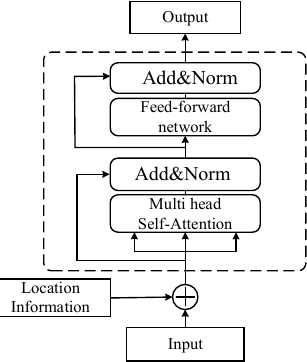
Figure 2. Transformer encoder model architecture.